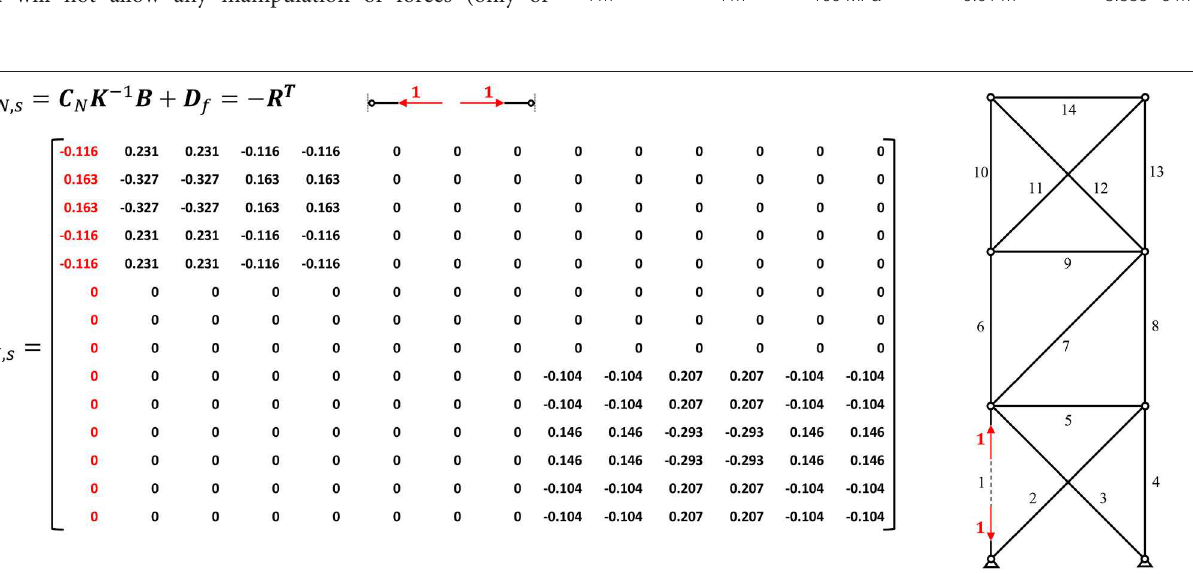
Frontiers in Built Environment |